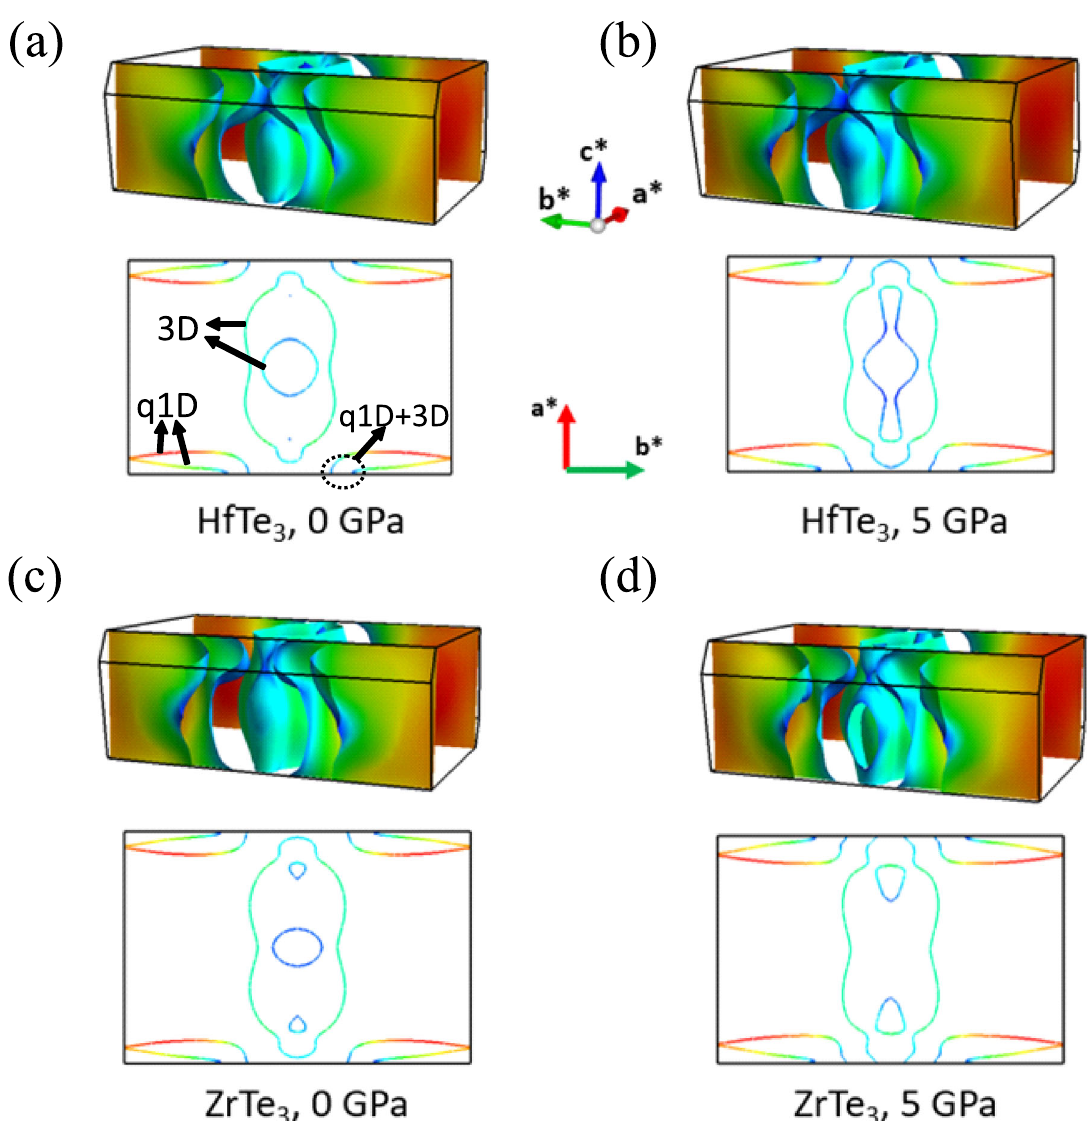
Fig. 10 Pressure effect on the Fermi surfaces of HfTe 3 and ZrTe 3 . The calculated Fermi surface sheets of a , b HfTe 3 and c , d ZrTe 3 at 0 GPa and 5 GPa, respectively. The color scales on the Fermi surface represent the Fermi velocities, where the pure red and pure blue correspond to the highest and zero Fermi velocities, respectively. The bottom fi gures in each panel are the sections of Fermi surface sheets at the c * = 0